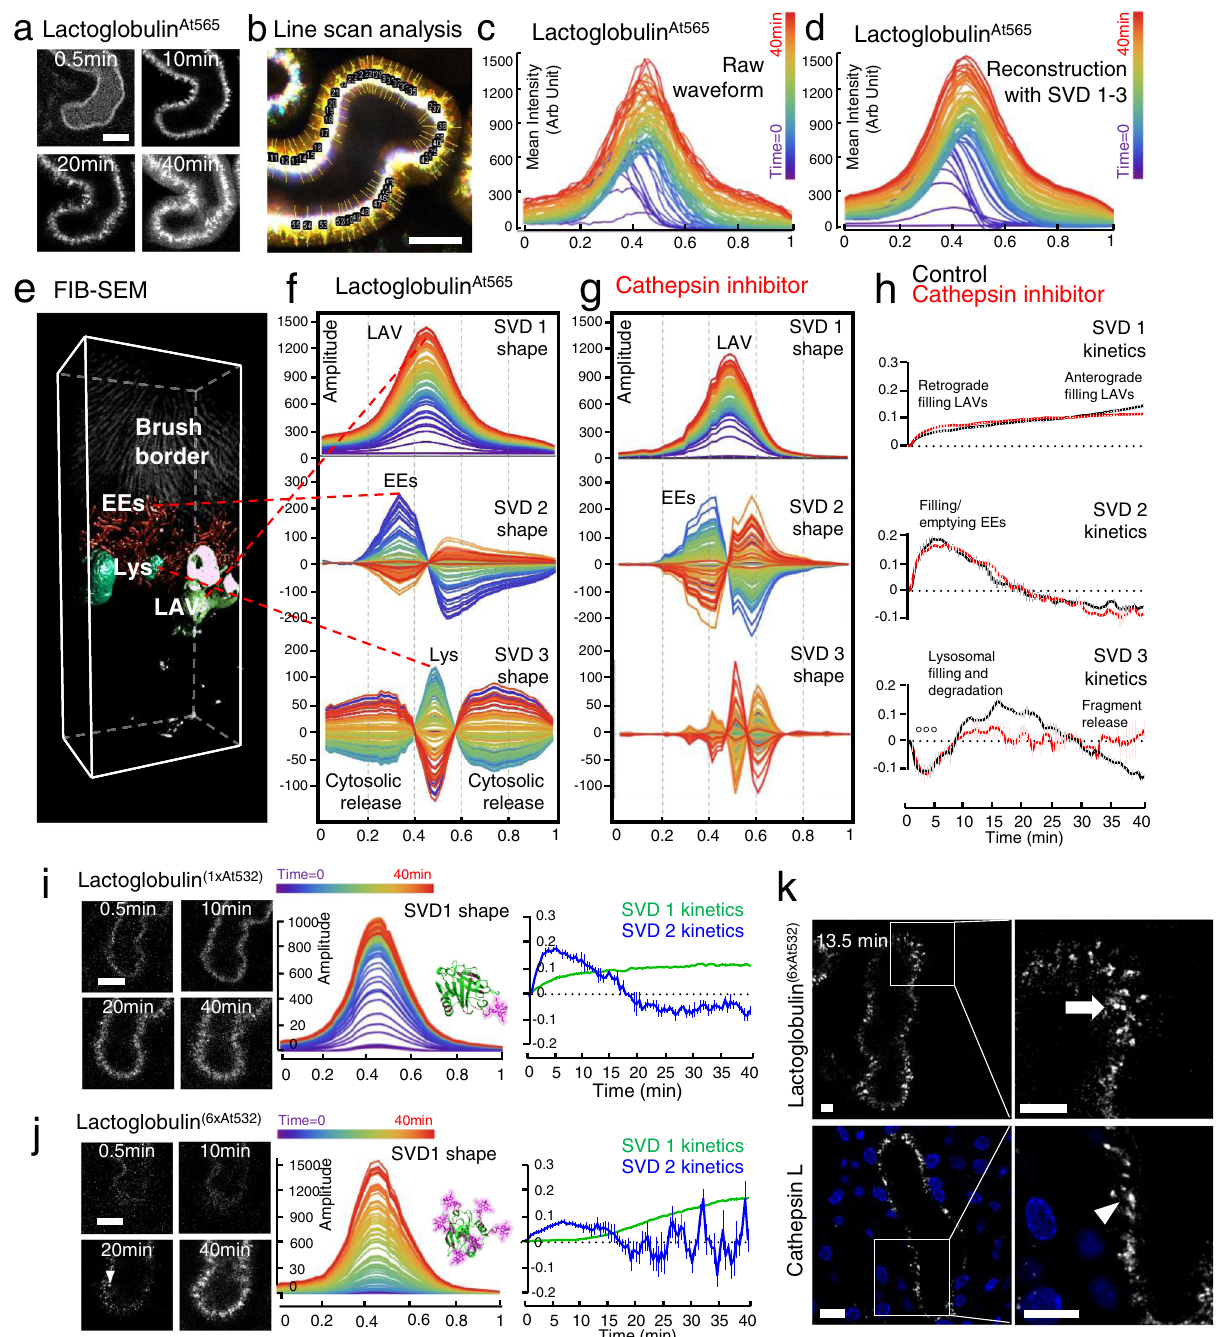
Fig. 5 | Derivation of protein processing kinetics in S1 cells in vivo. a High resolution single plane images of S1 cells post intravenous injection of lactoglo- bulin At565 (representativeofthreeindependentexperiments). b LinescanROIswere drawn across cells using sum images (representative of three independent experiments). c Representative raw intensity waveform showing normalized evo- lution of intracellular fl uorescence distribution over time (0=apical side, 1=basolateral). d Reconstruction from three independent base vectors derived from SVD analysis. e – g The spatial shape and time evolution ofthe individualbase vectors is depicted (0=apical side, 1=basolateral), under control conditions ( f ), and with a cathepsin inhibitor (e64) ( g ). Cross-referencing to the 3-D reconstruc- tion from FIB-SEM suggests that base vectors localize to major endo-lysosomal structures (LAV large apical vacuoles, EE early endosomes, Lys lysosomes). h Plots depictingkineticchangesinamplitudeofSVD1-3(meanvalue±SEM; n =3miceper group), and showing loss of lysosomal degradation and fragment release with the cathepsin inhibitor (°°° p <0.001). i , j SVD1 displays biphasic kinetics. i Post